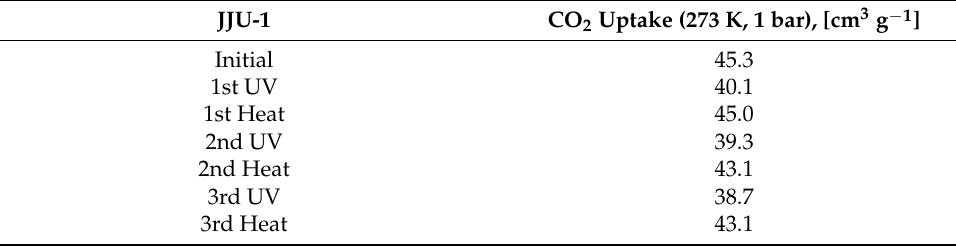
Table 2. Summary of CO 2 adsorption properties of